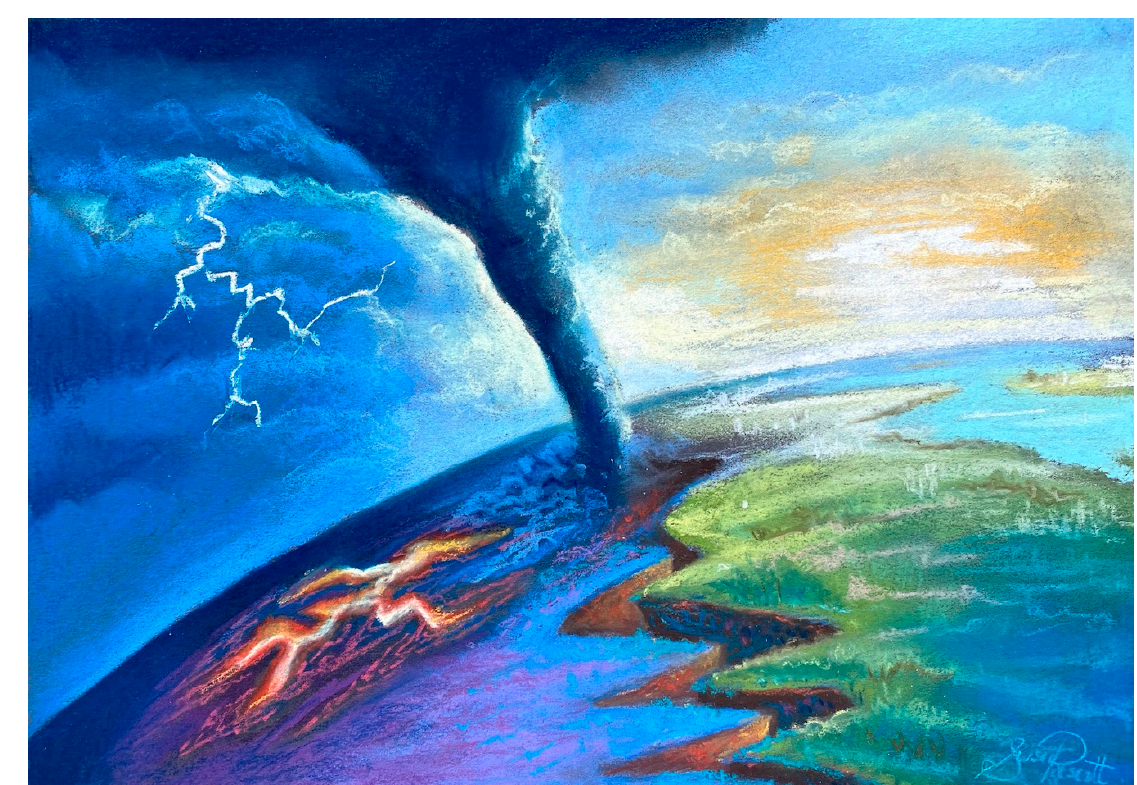
Figure 4. Challenges that break the status quo can provide new or accelerated opportunities for change. Acute events can unmask chronic problems that seemed impossible to overcome or may not have even been recognized. The new perspectives and greater awareness that result can create new possibilities and galvanize action. What applies to personal growth may apply equally at collective scales. (Artwork by S.L.P.).